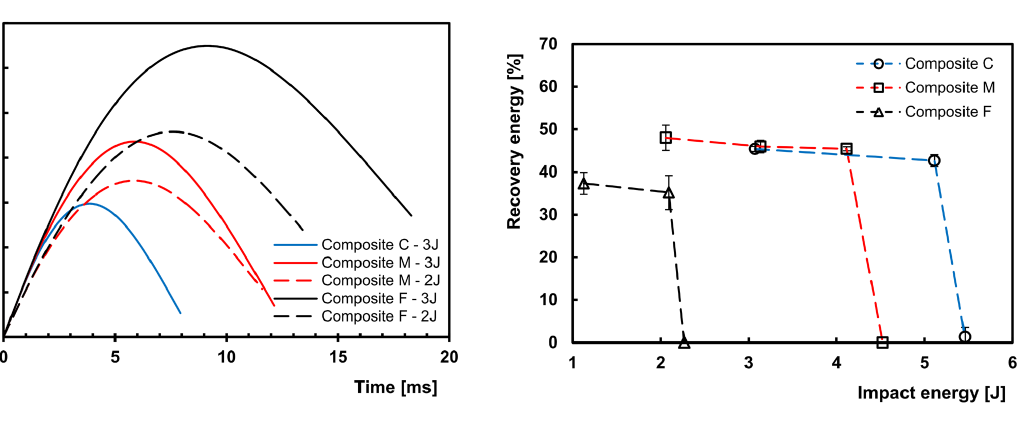
Figure 10. Examples of deformation curves versus time. Figure 12. Recovery energy versus the impact energy.